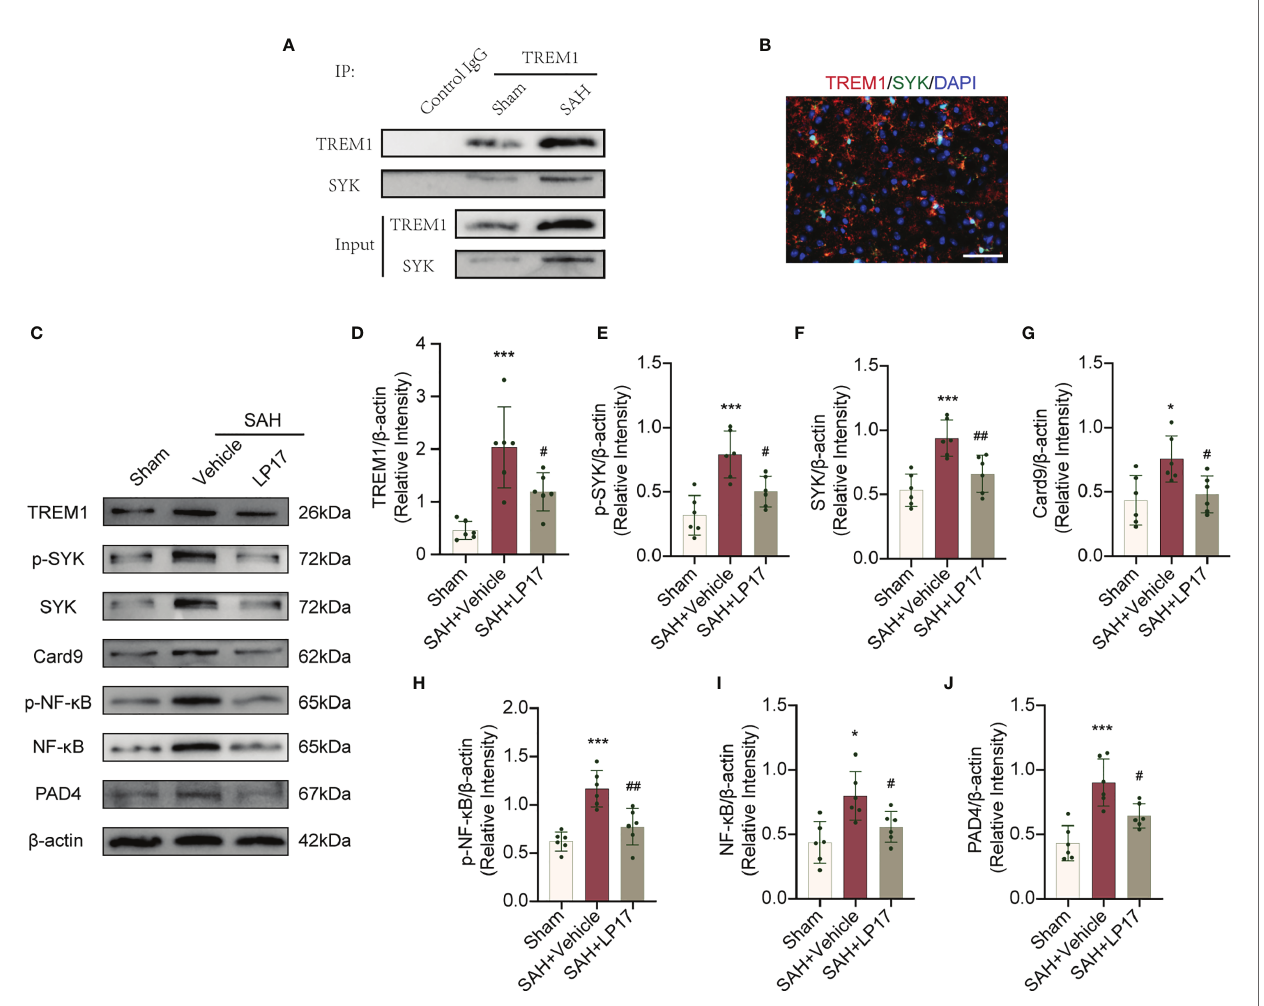
FIGURE 7 | TREM1 triggered the Card9/NF- k B and PAD4-NETs signaling pathway through interacting with SYK. (A) The lysates from cortex tissue were immunoprecipitated with anti-TREM1. Then immunoprecipitates were analyzed by immunoblotting with anti-TREM1 and anti-SYK. n = 6/group. (B) Immunostaining for TREM1 and SYK in cerebral cortex. n = 3/group. Scale bar = 50 m m. (C – J) . Representative western blotting images and quantitative analysis of TREM1, p-SYK, SYK, Card9, p-NF- k B, NF- k B, and PAD4 in cortex in different groups. Control images of b -actin are re-used for illustrative purposes. n = 6/group. Data are expressed as mean ± SD. *P < 0.05, ***P < 0.001 vs Sham group; # P < 0.05, ## P < 0.01 vs SAH+vehicle